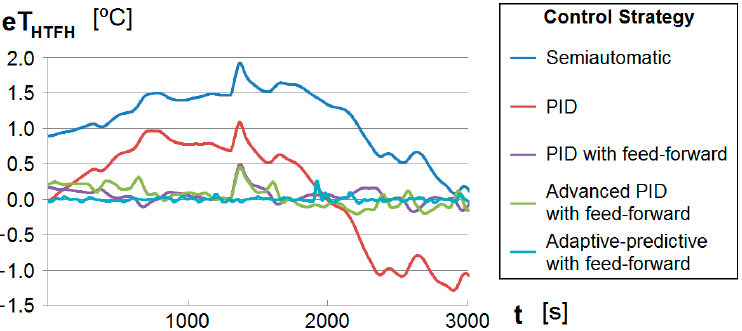
Figure 9. Evolution of the error obtained with different control strategies.